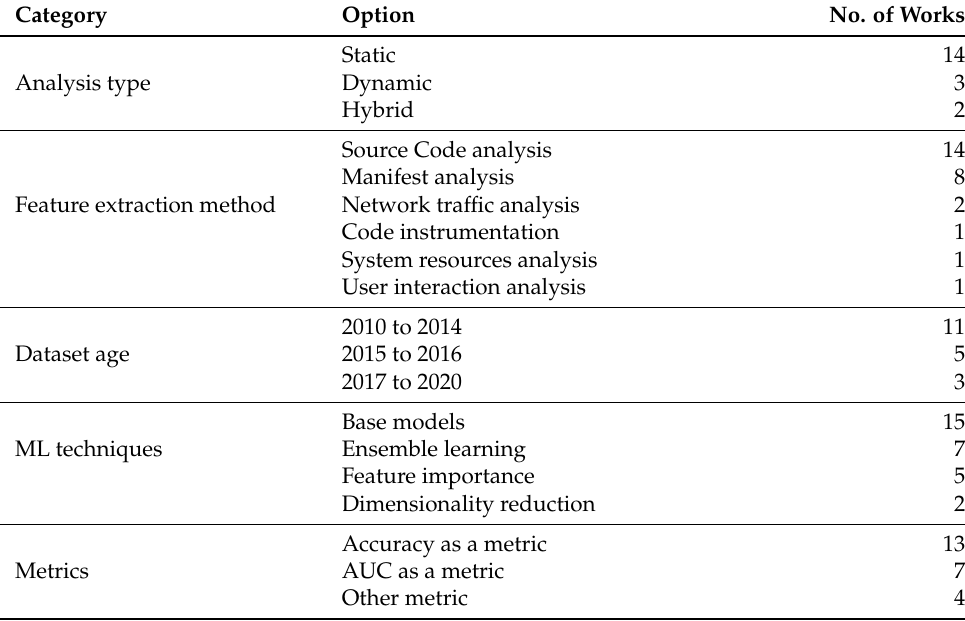
Table 4. Summary of key characteristics observed across the surveyed